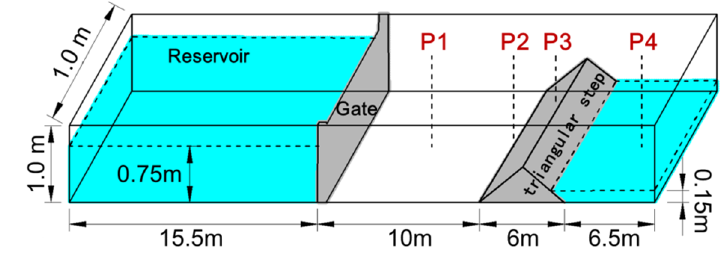
Figure 6. Sketch of dam-break flow over a triangular step.